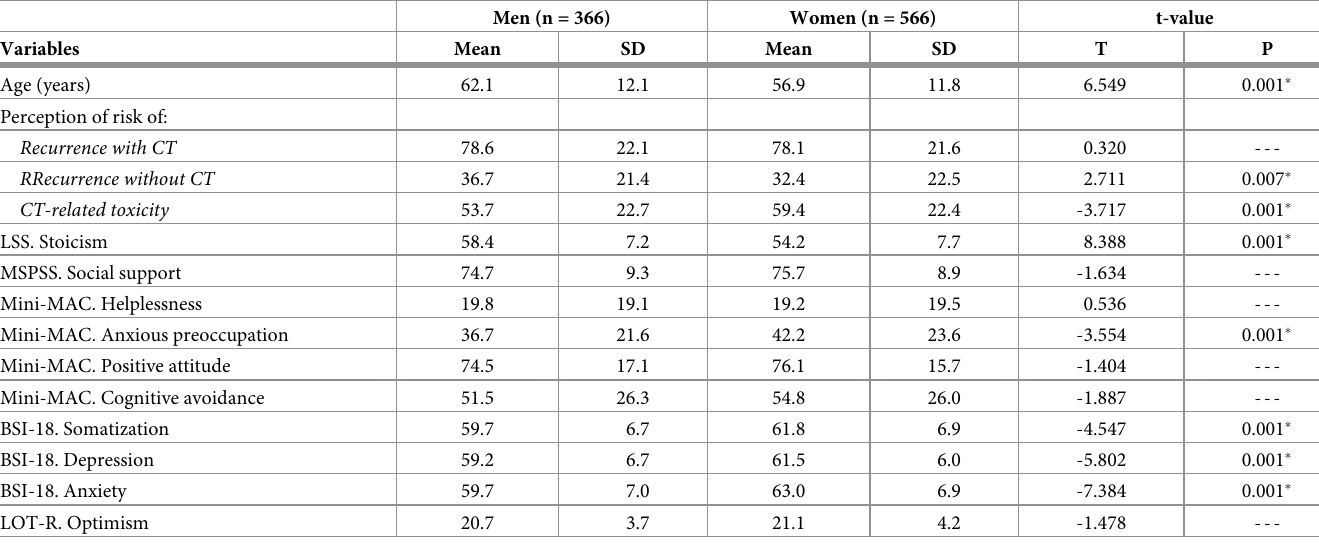
Table 2. Gender differences in age, perception of risk of recurrence and toxicity, stoicism, and psychological scales in patients with cancer. Men (n = 366) Women (n = 566) t-value Variables